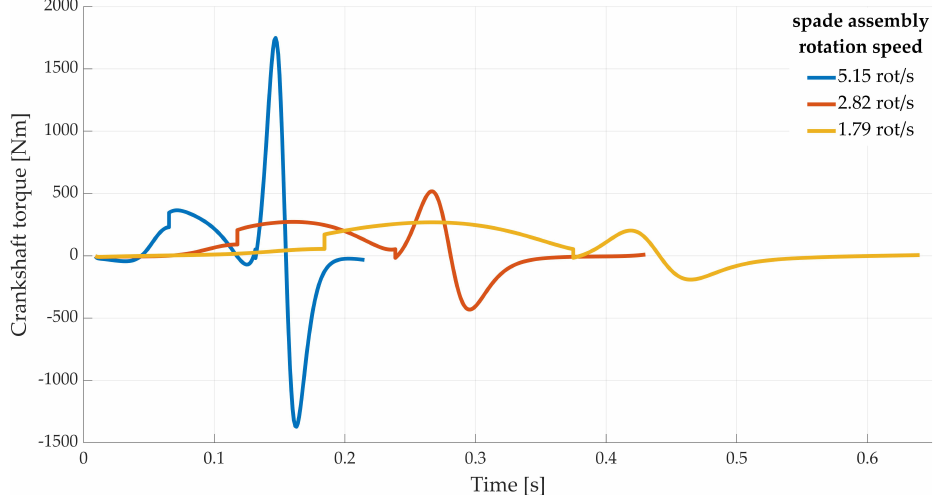
Figure 10. Effect of bit load on the crankshaft torques using working depth of 0.28 m and machine advancing speed of 0.35 m/s (first cycle